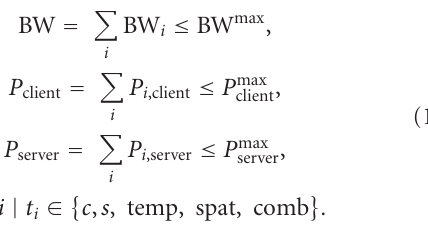
Algorithm 1 is described in the following paragraphs and ta-